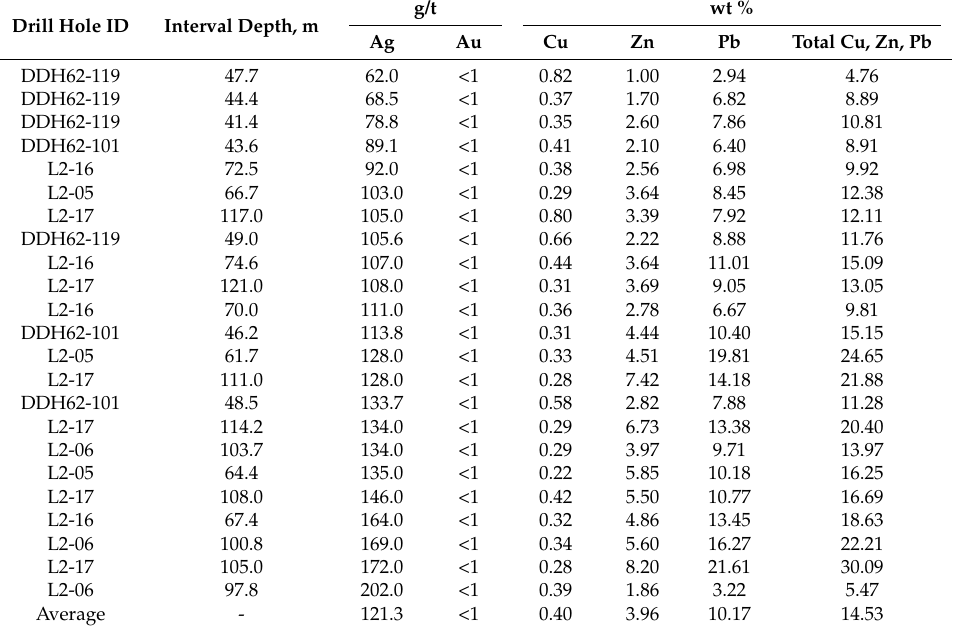
Table 1. Lens 3 drill core interval assay results.